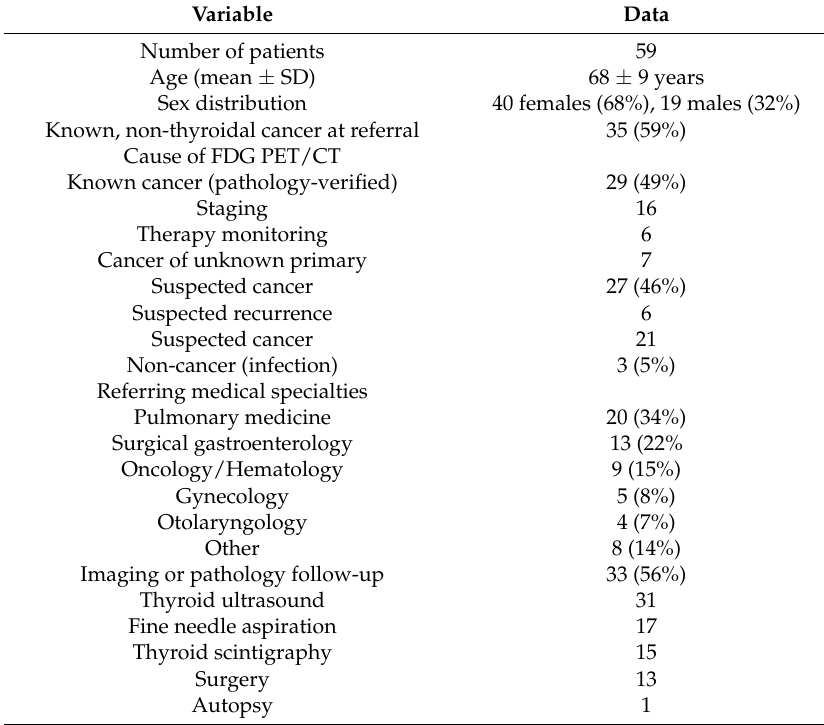
Table 1. Patient demographics, follow up, and final pathological diagnosis among the 59 patients with FDG-avid focal thyroid